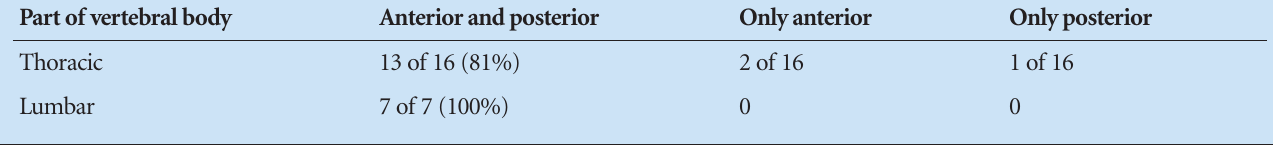
Table II. Distribution of partial destruction